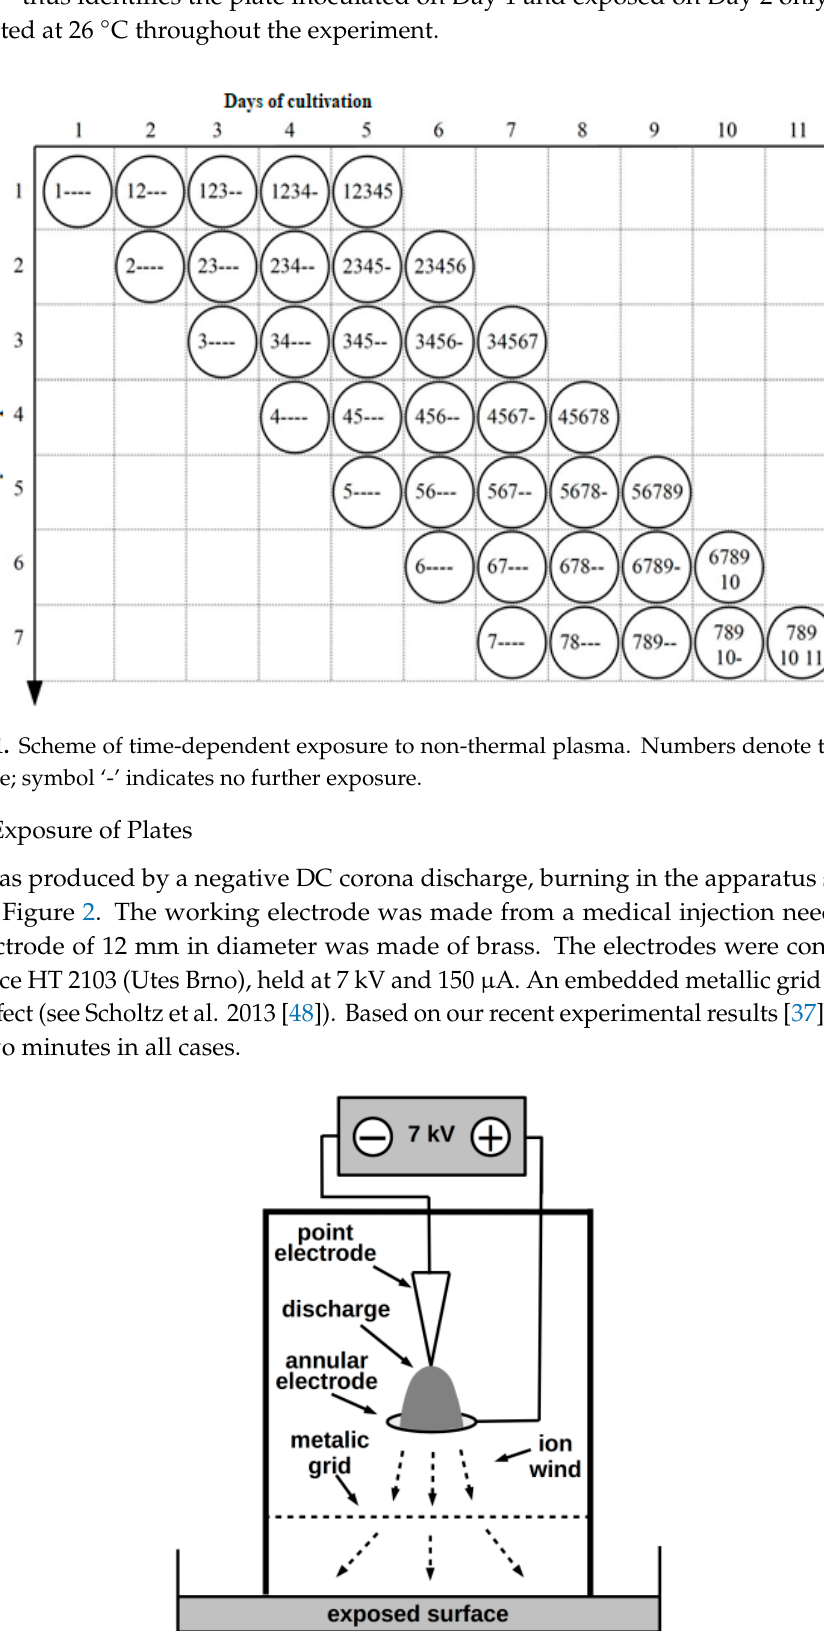
Figure 2. Scheme of the NTP source.